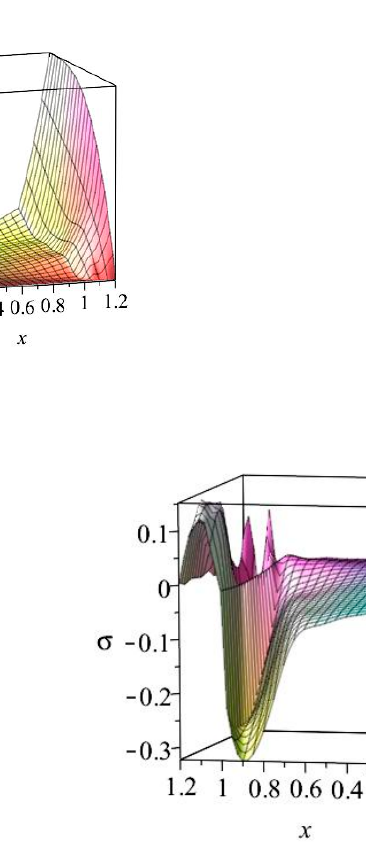
Figure 6. The thermal conductivity coefficient increased by four times for thermal conductivity coefficient for layer 2, and two times for a greater thickness of layer 2.